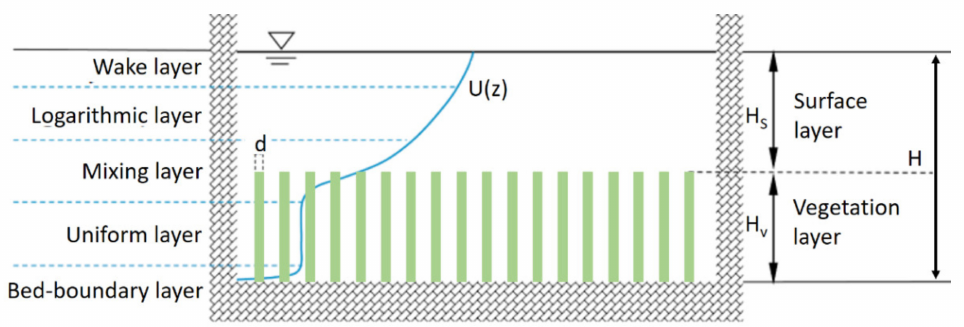
Figure 1. Schematic diagram of flow with vegetation; source: Shi et al.